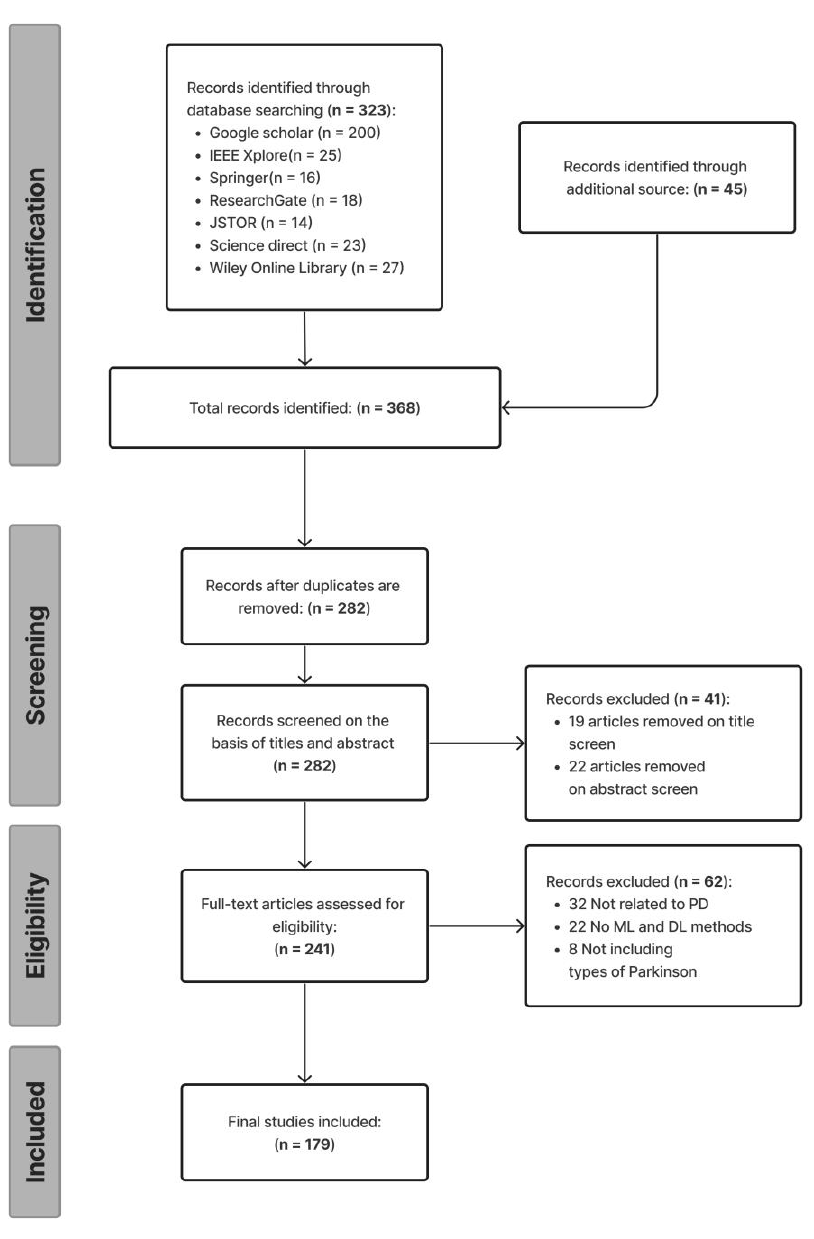
Figure 2. Selection of articles based on PRISMA technique.